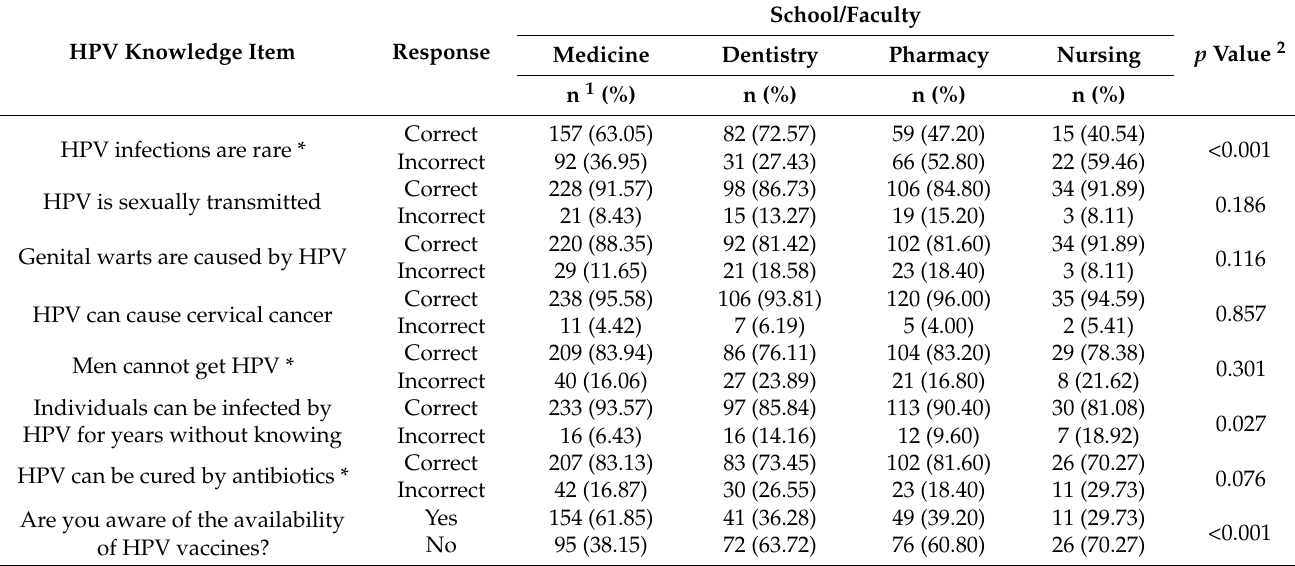
Human papillomavirus (HPV) level of knowledge stratified based participant affiliation to different